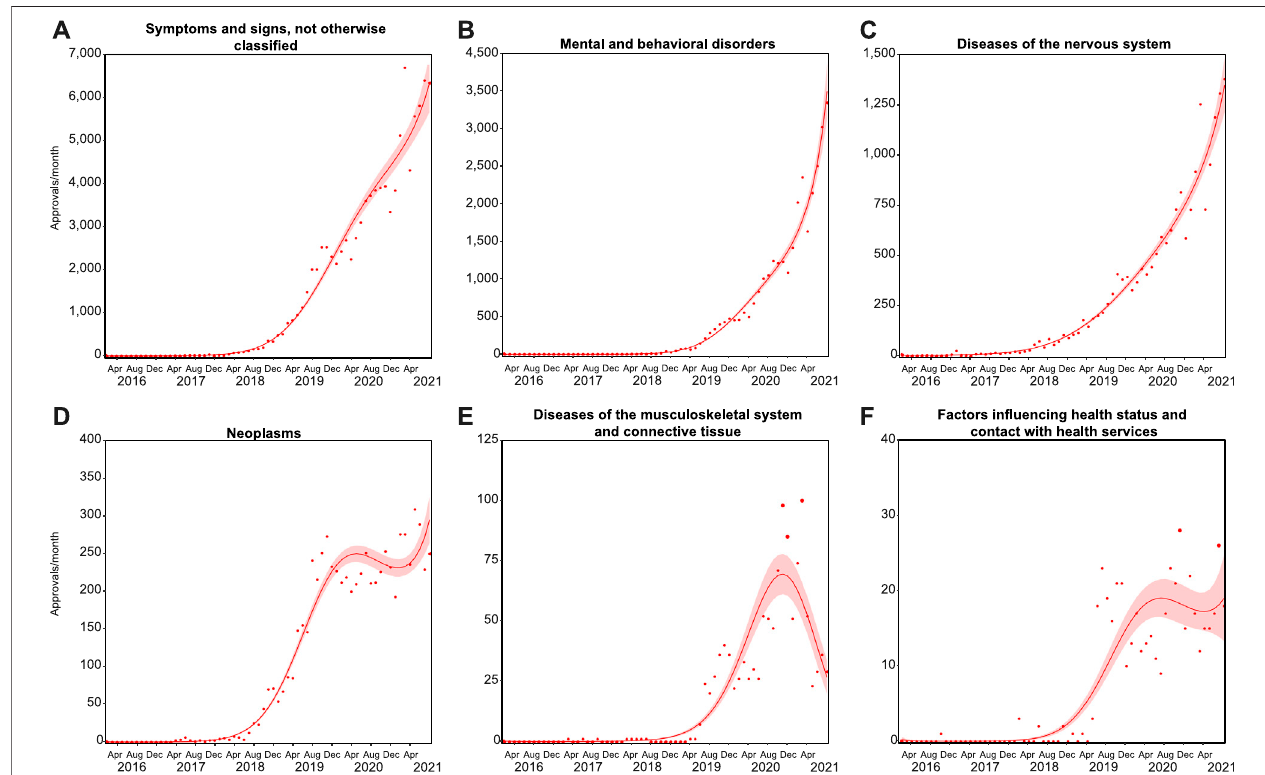
FIGURE 2| Growth across indication groups differs. Trends in monthly approvals over time were analyzed in six ICD-10 groups representing almost all cumulative approvals( SupplementaryTableS1 ).Approvalsforsymptoms,signsandabnormalclinicalandlaboratory fi ndings,notelsewhereclassi fi ed (A) ;mentalandbehavioral disorders (B) ; neoplasms (C) ; and diseases of the nervous system (D) followed Negative binomial, 4th degree polynomial curves (R 2 = 0.989, 0.993, 0.976, and 0.976, and Δ m=7.055,18.903,20.462,and6.037,respectively).Approvalsfordiseasesofthemusculoskeletalsystemandconnectivetissue (E) ;andfactorsin fl uencing health status and contact with health services (F) followed Negative binomial 3rd degree polynomial curves (R 2 = 0.894 and 0.831, and Δ m = 83.058 and 49.676, respectively). Solid lines represent the best fi t with shaded standard error of the mean.